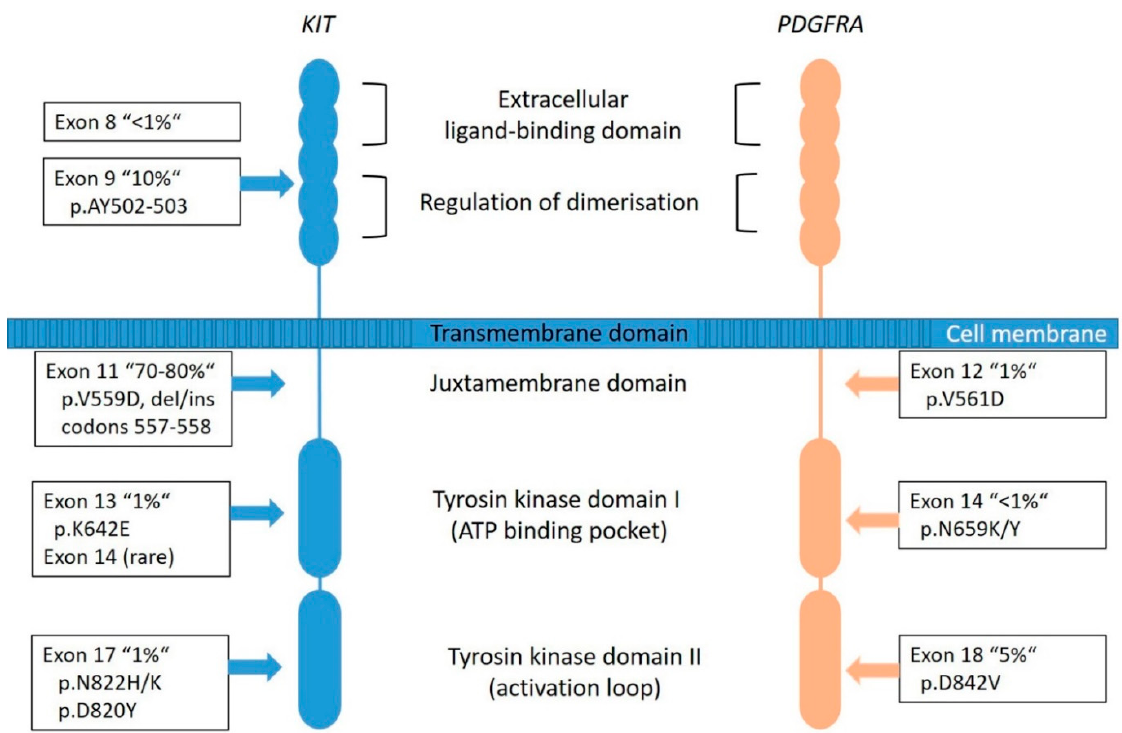
Figure 3. Graphical representation of KIT and PDGFRA transmembrane tyrosine kinase receptors with frequency and localization/distribution of primary mutations found in sporadic GIST (adapted from [53,54]).